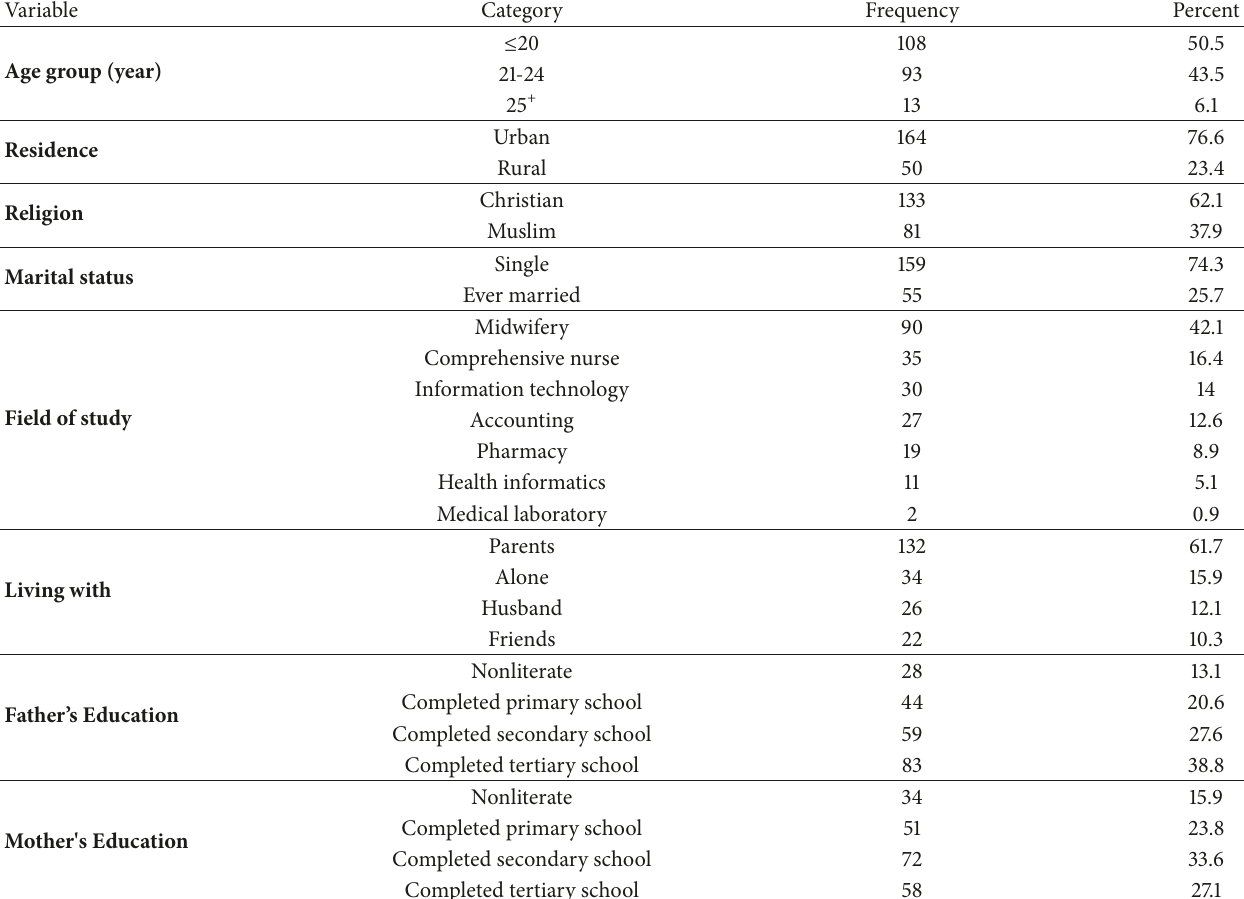
Figure 1: Schematic presentation of sampling procedure. # Total number of graduating class female students in each college and departments. $ Sample size proportionally allocated to each college and departments. Comprehensive Nurse (CN); Midwifery (MW); Pharmacy (PH); Medical Laboratory (ML); Accounting (AC); Information Technology (IT); Health Informatics (HI). Table 1: Sociodemographic characteristics of female college graduating students in Harar town, eastern Ethiopia, 2016 (N=214).